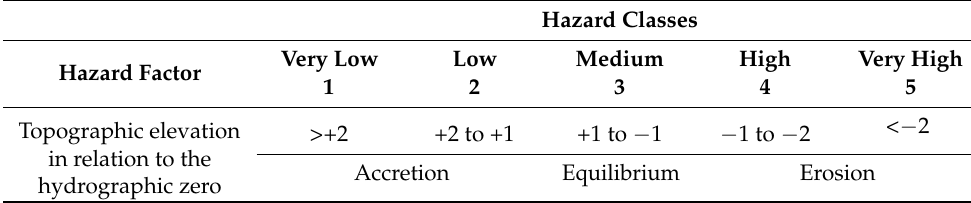
Table 6. Hazard classification concerning the erosion/accretion rates hazard